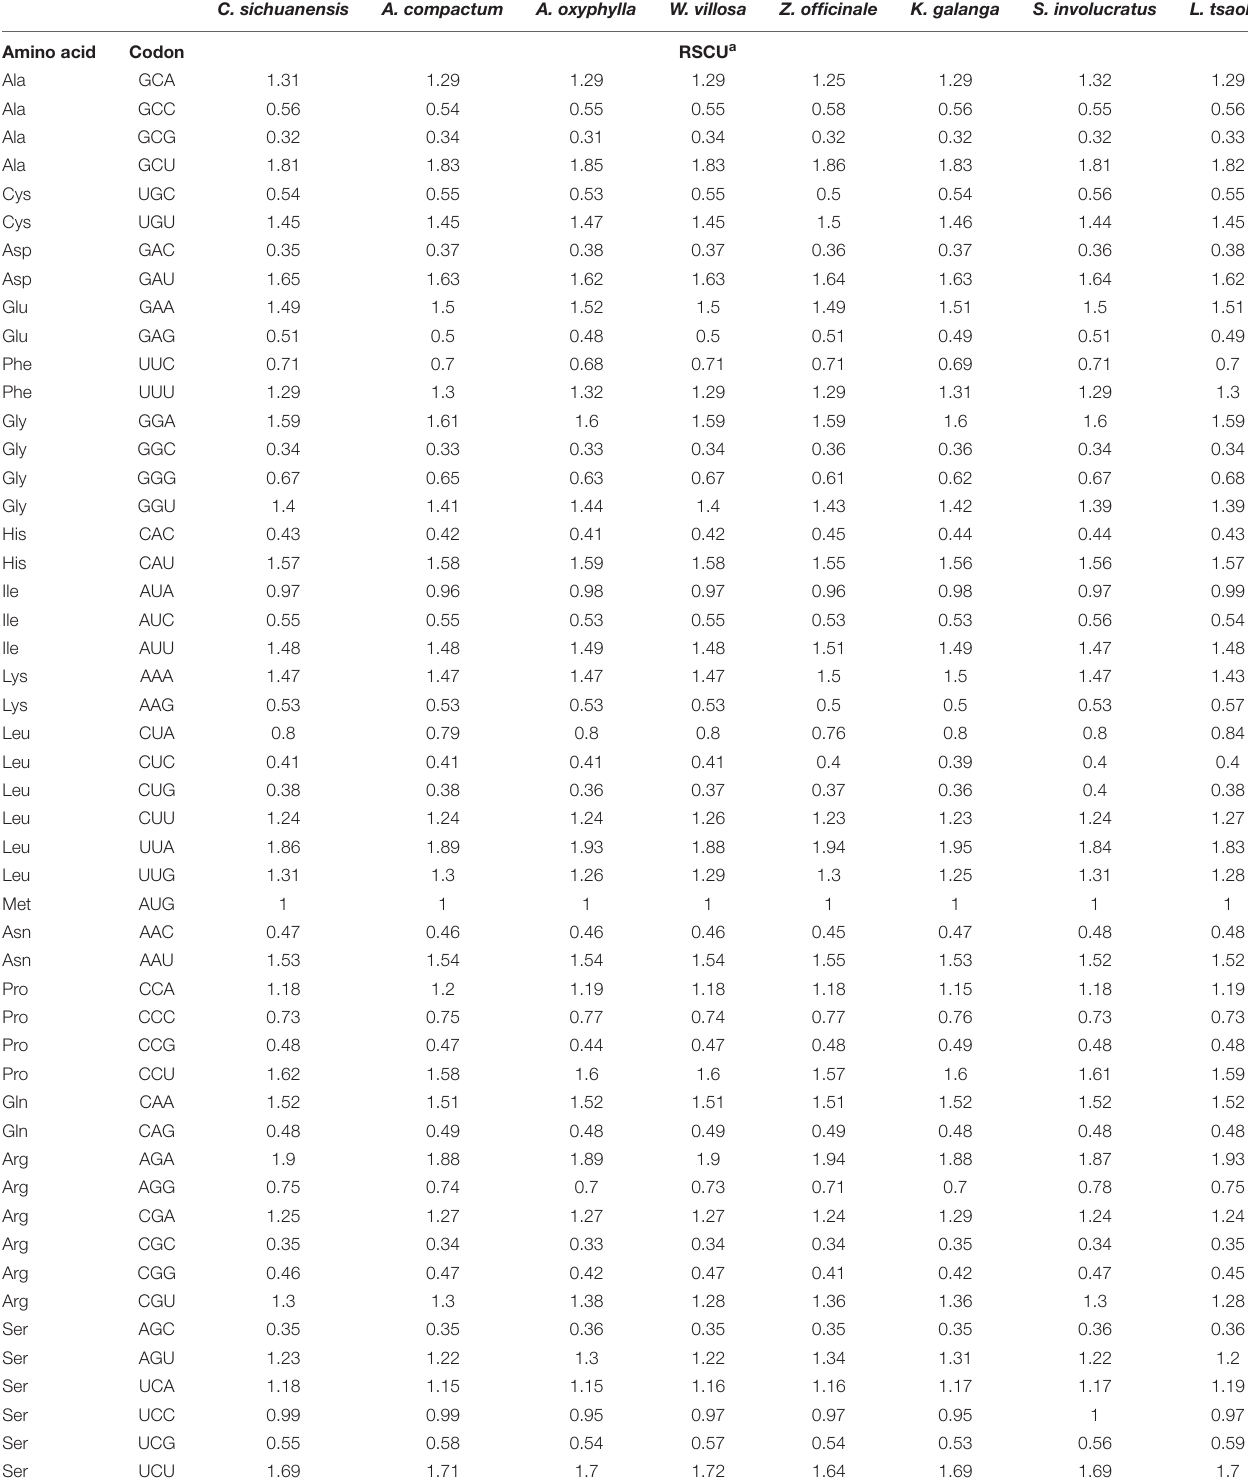
TABLE 4 | Codon content of amino acid and stop codon of 8